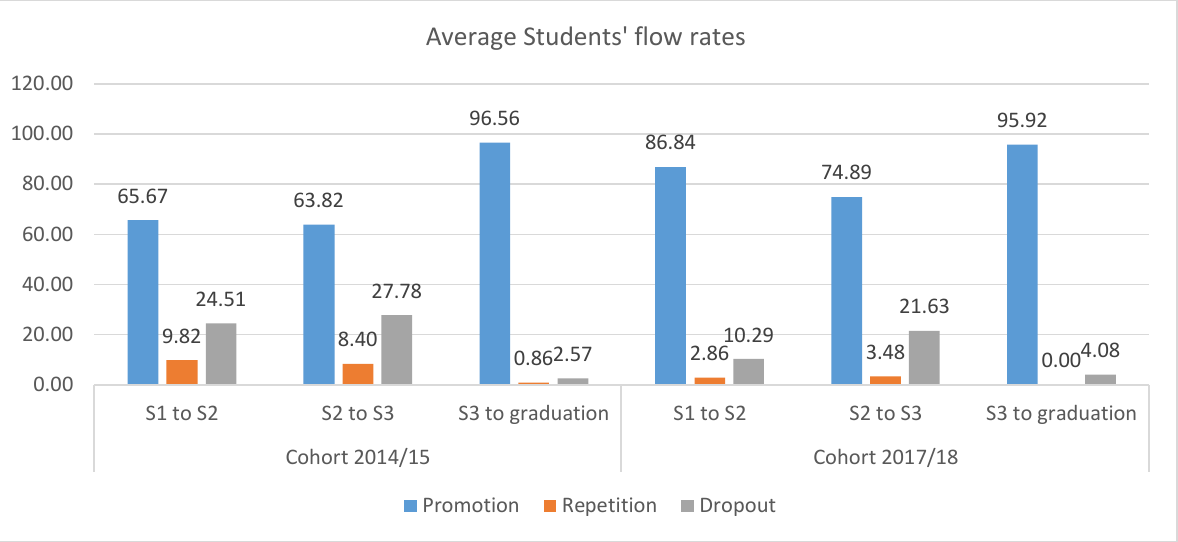
Figure 3: Comparison of students’ flow rates between the cohort 2014/15 and